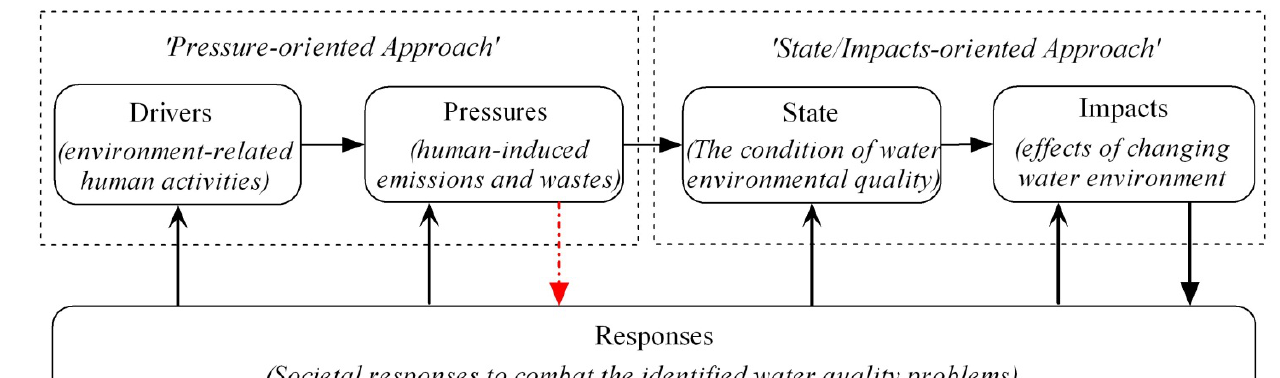
Figure 1. The pressure-oriented and state/impacts-oriented water quality monitoring approaches based on the DPSIR framework (the dashed red arrow shows the emphasized shortcut to effectively respond to water environmental degradation in the present study).